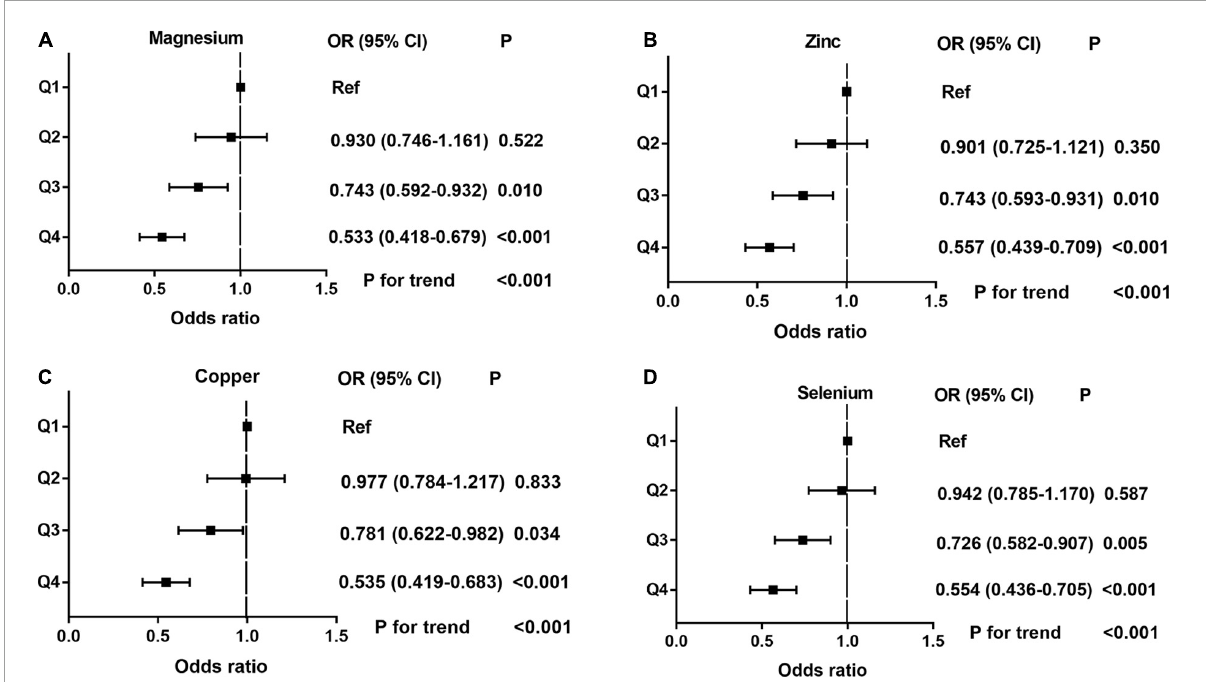
FIGURE3 The adjusted odds ratios (95% CI) of dietary metal intake and erectile dysfunction before propensity score matching. (A) Magnesium; (B) Zinc; (C) Copper; and (D) Selenium.